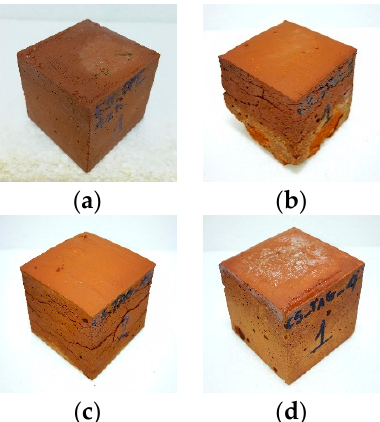
Figure 5. Photos of geopolymers: ( a ) optimum synthesis, ( b ) WBG_8, ( c ) WBG_14 and ( d ) WBG_4.